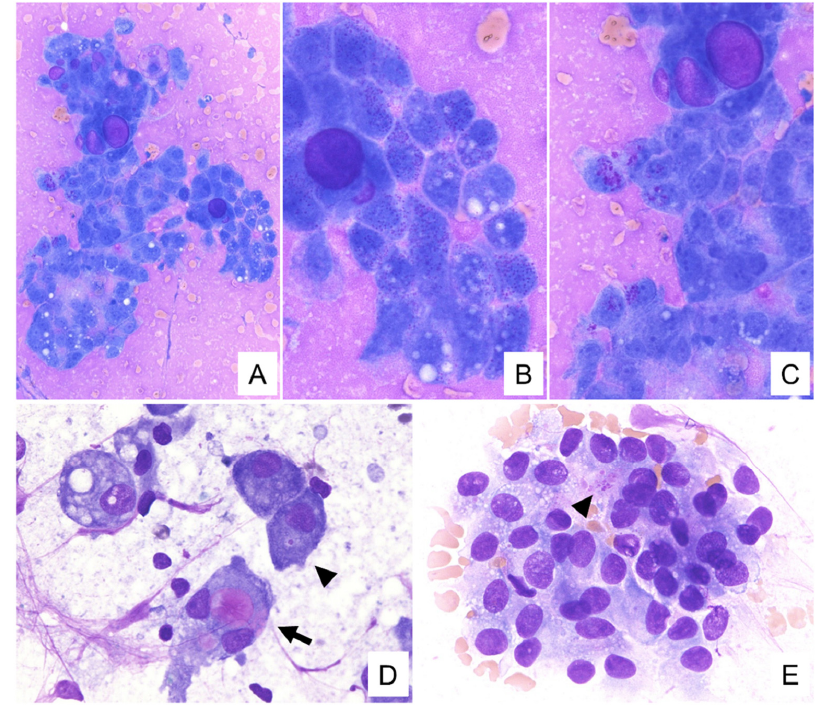
Figure 3. Cytologic findings of Giemsa staining. ( A ) The metachromatic mucin is spread evenly across the background, and metachromatic hyaline globules surrounded by neoplastic cells are visible. ( B , C ) Various sized vacuoles and metachromatic granules are in the cytoplasm. ( D , E ) Metachromatic secretions (( D ), allow) and granules (( D , E ), allow heads) are present in the cytoplasm (( A – C ): case 1, ( D ): case 3, ( E ): case 4. ( A ): ×200, ( B – E ): ×600).